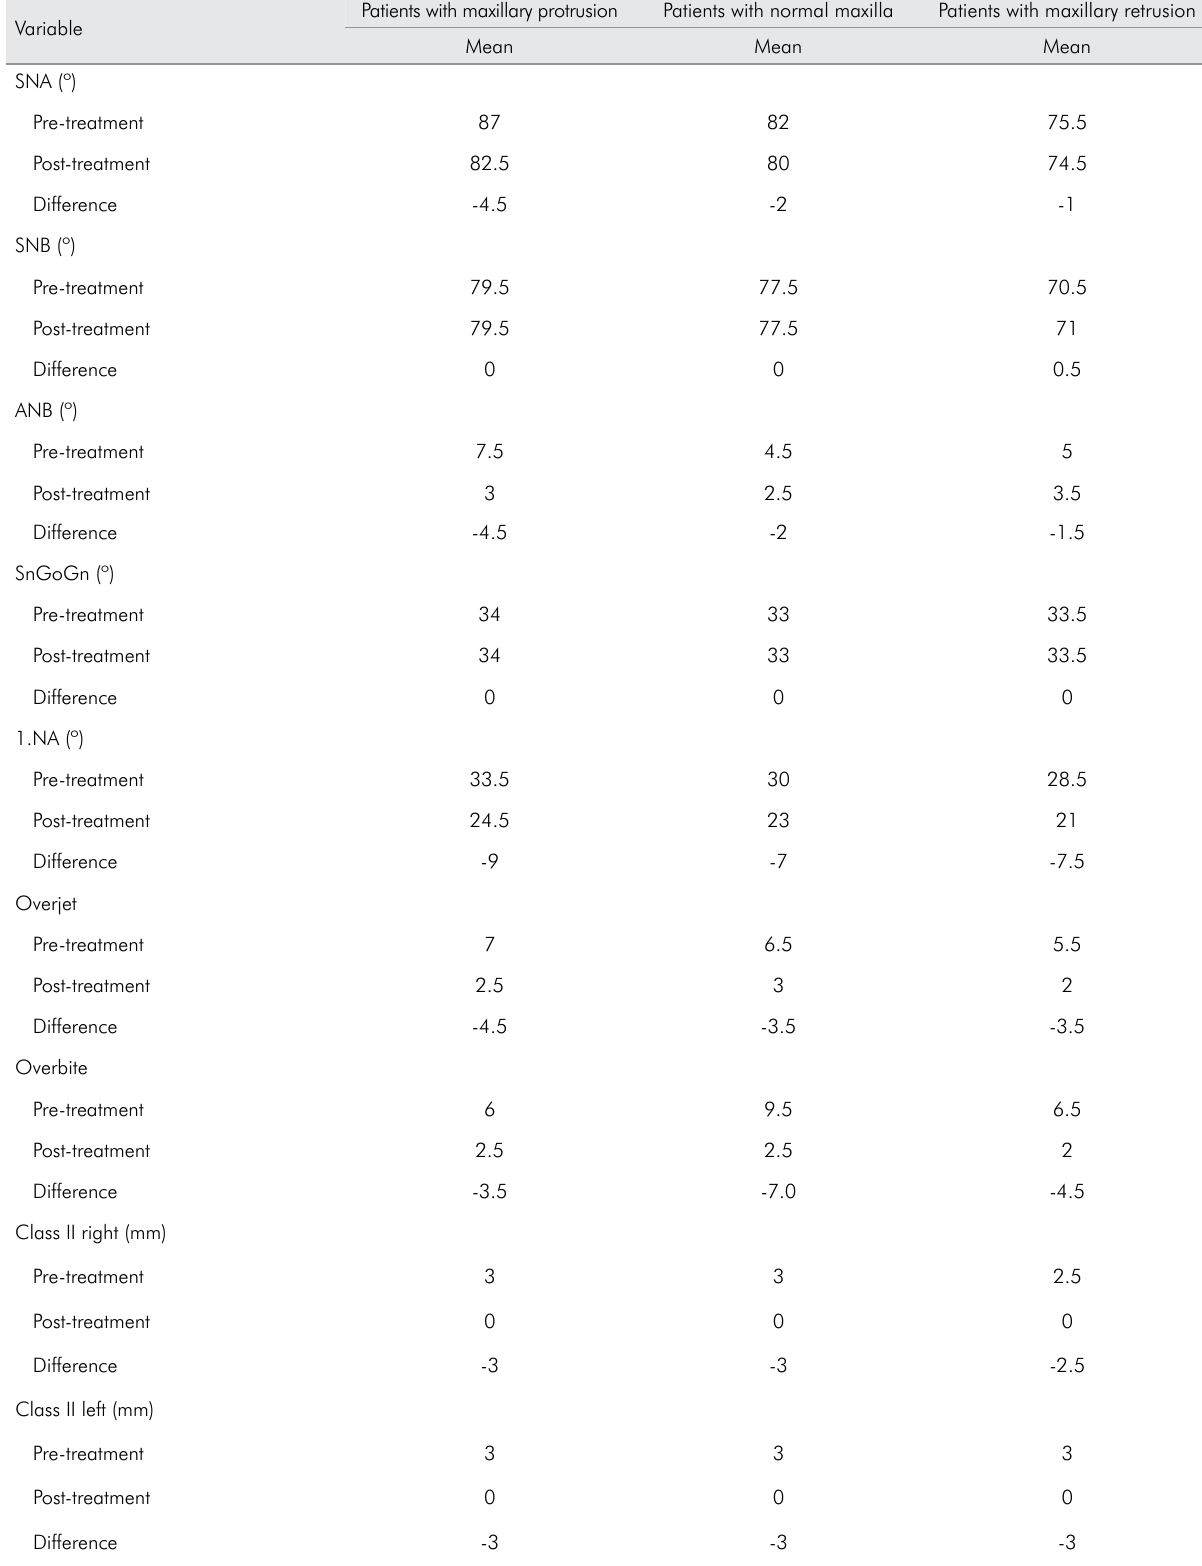
Table 1. Pre-treatment and post-treatment linear and angular measurements of patients used for constructing the profile silhouettes.